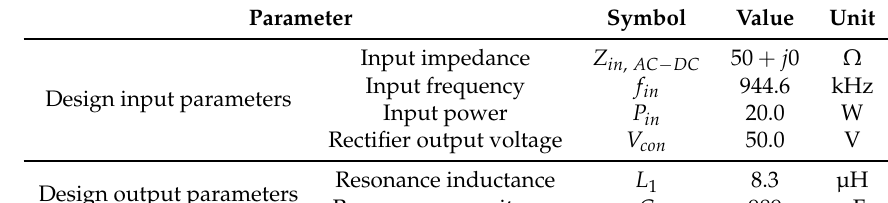
Table 2. Parameters of the AC-DC converter used in the system.